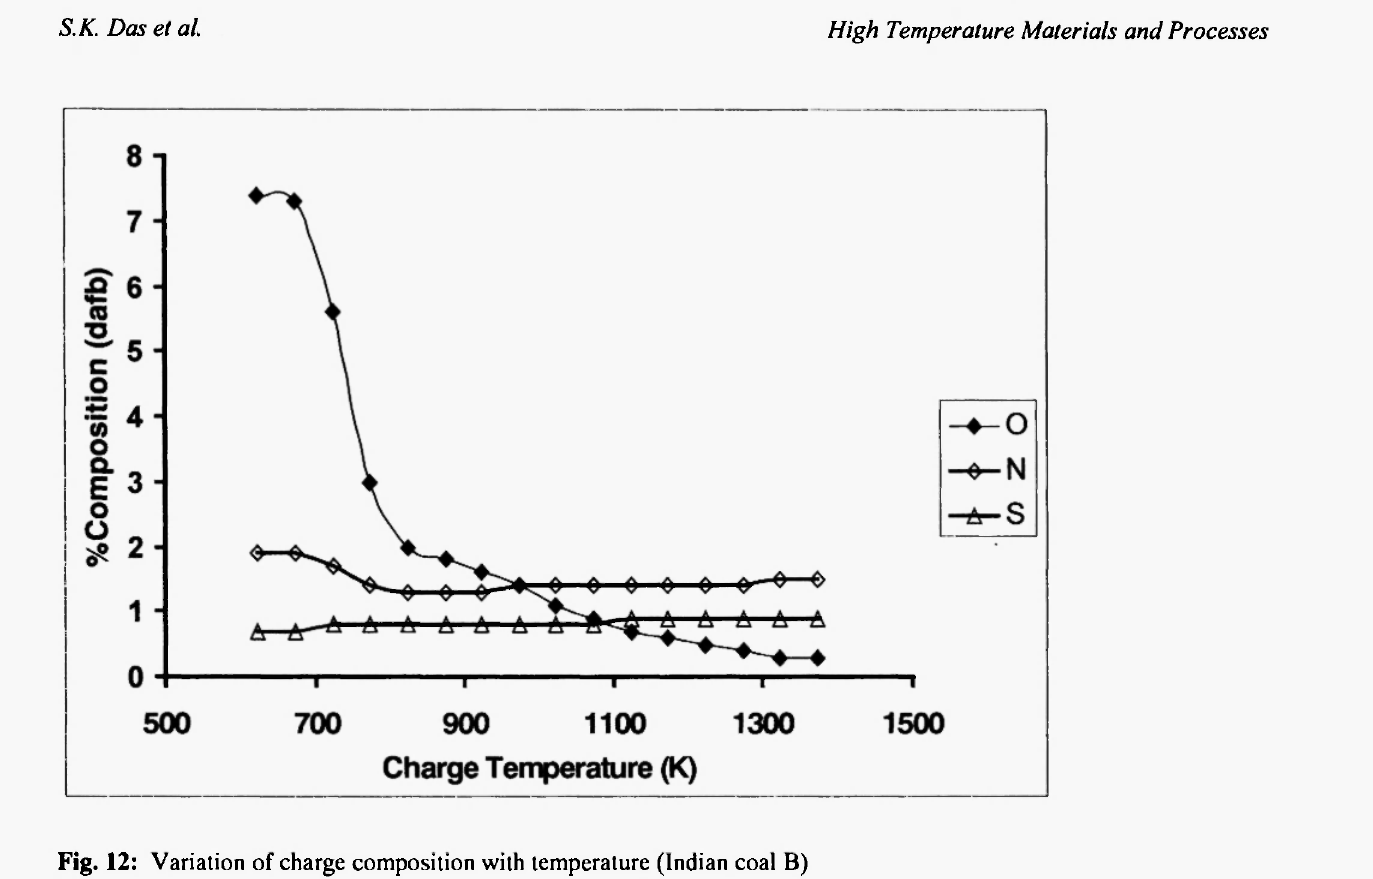
Fig. 12: Variation of charge composition with temperature (Indian coal B)